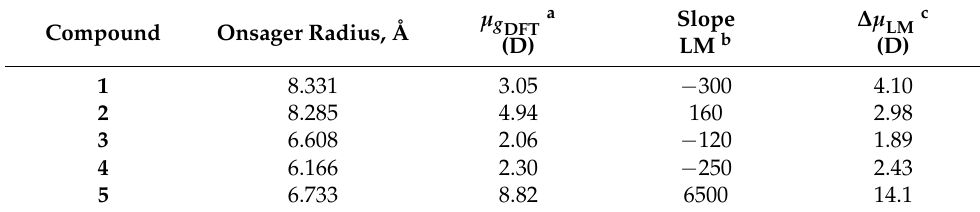
Figure 5. Lippert-Mataga plot for 5 . Stokes shift derived from absorption and emission maxima (Table 2) in wavenumbers (cm −1 ). Orientation (solvent) polarizability ( 𝑓 1 (𝜖, 𝜂)) of solvents calculated from Equation (3). Conditions: 1 μ M at 25 °C. Table 3. Solvatochromic Data for 1 – 5 .